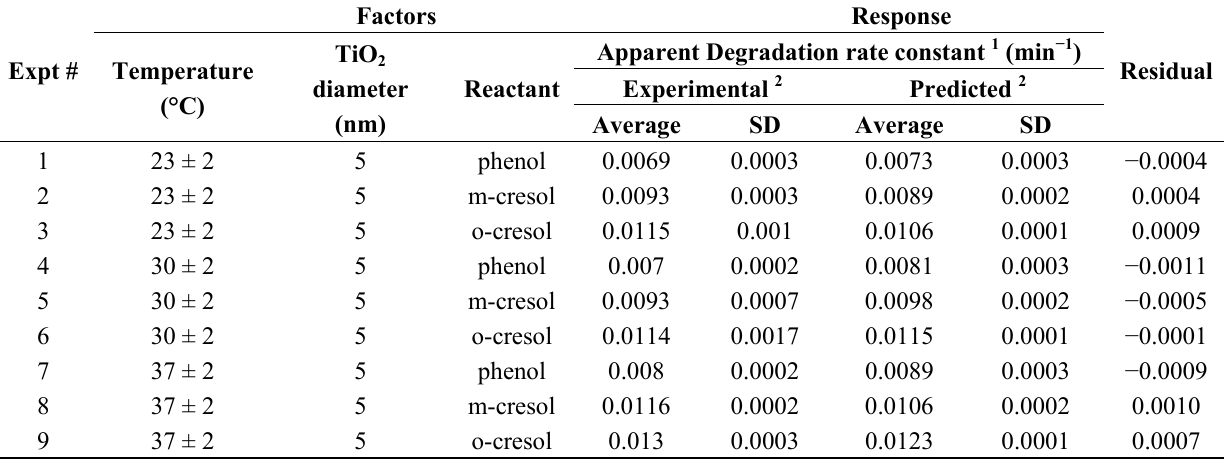
Table 3. Photocatalytic reaction apparent degradation rate constants for different experimental